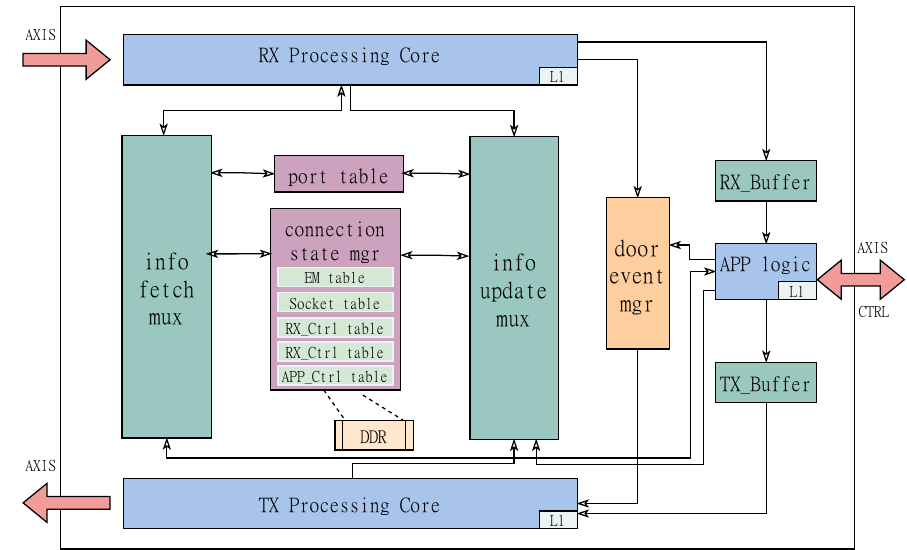
Figure 1. TOE system structure